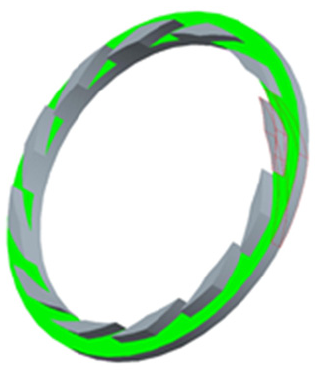
Figure 2. Three-dimensional model of lubricating film.